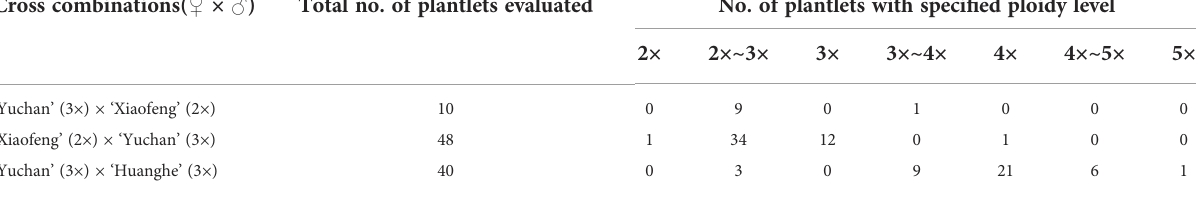
TABLE 2 Ploidy level of hybrid progenies resulted from crosses with sexual triploid Cymbidium . Cross combinations( ♀ × ♂ ) Total no. of plantlets evaluated